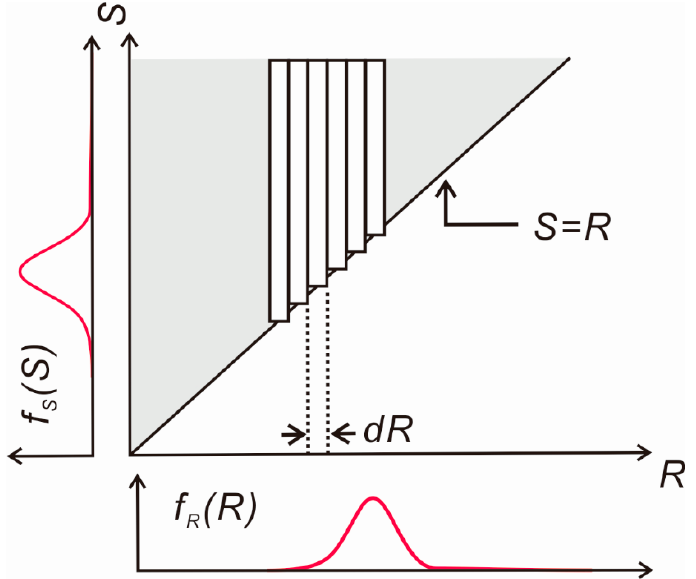
− R S plane corresponding to the